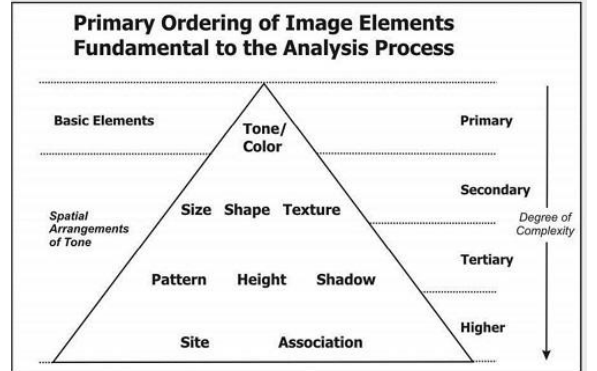
Figure 2. Basic elements of image interpretation arranged by increasing complexity (source: Estes et al. (1983)) So, cues such as shape and size are difficult to exploit in images of outdoor scenes, resulting in the exploration of tone, colour and texture only in remote sensing classification tasks.